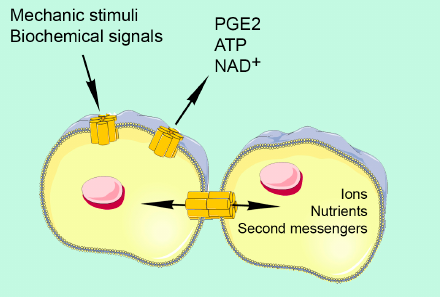
Figure 1. Schematic representation of gap junctions and hemichannels in bone cells.